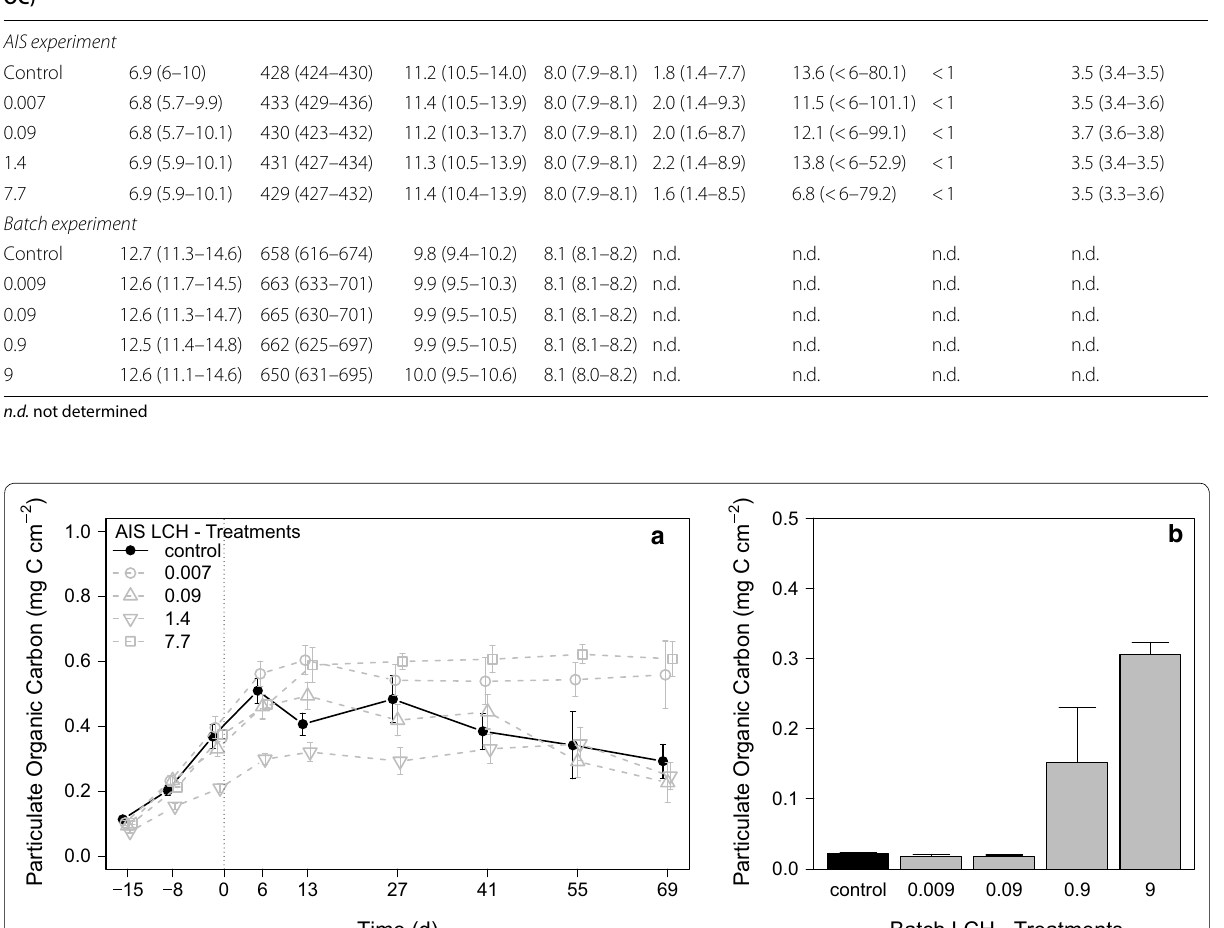
SE, n 6] and b at the end of the LCH batch experiment [mean ± =